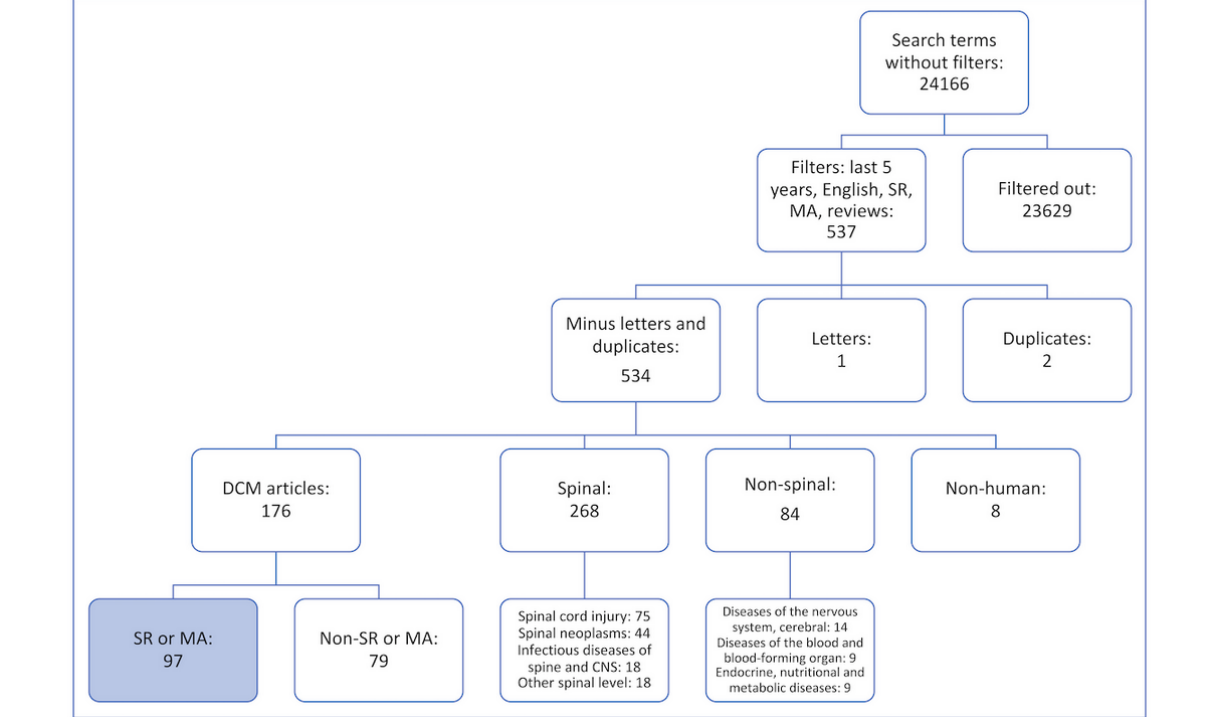
Figure 1. MEDLINE search strategy with the most common imprecision categories. CNS: cerebral nervous system; DCM: degenerative cervical myelopathy; MA: meta-analysis; SR: systematic